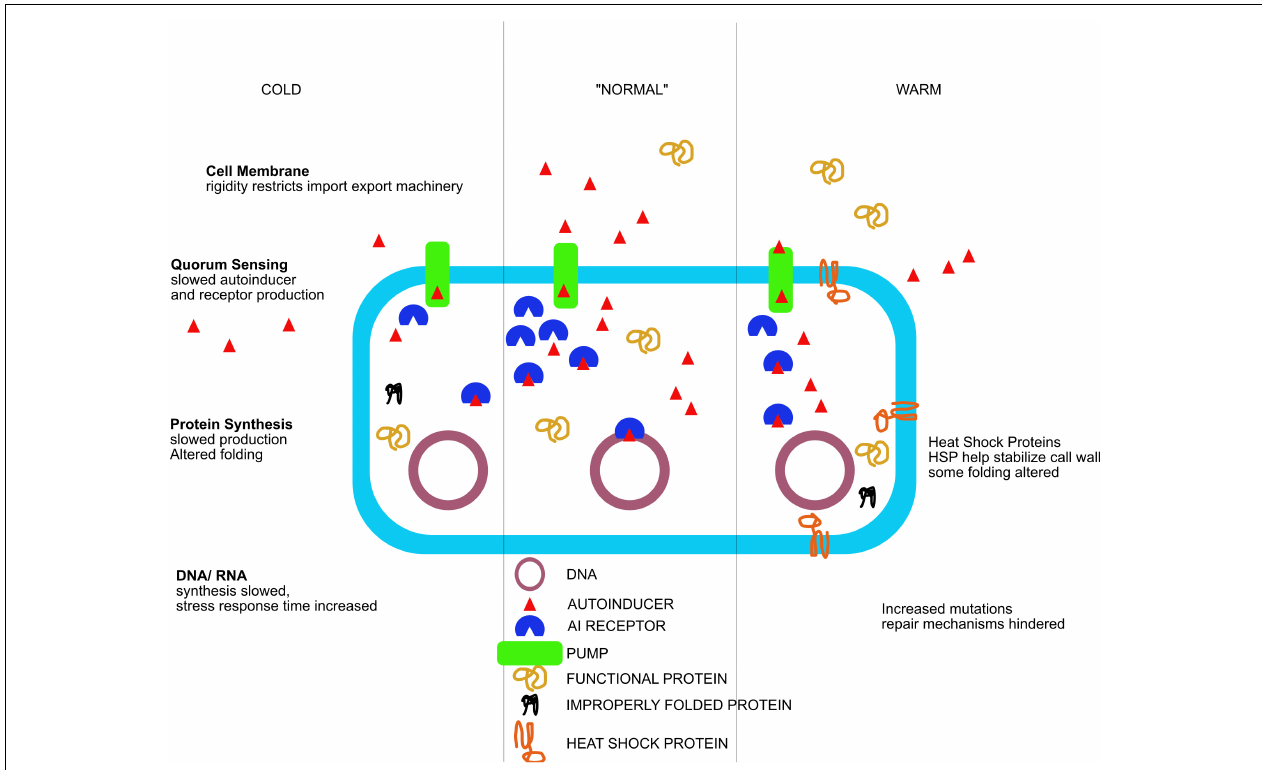
FIGURE 2 | The response of environmentally transmitted Vibrio fischeri to temperature stress as a driver for diversification. Cell features and processes are affected differently when presented with a cold (left side of figure), or hot (right side of figure) environmental challenge. Metabolic and signaling processes are altered in response to these temperature changes, effecting both genotype and phenotype. Subsequently, these adapted strains diversify and become a novel ecotype, possibly leading to